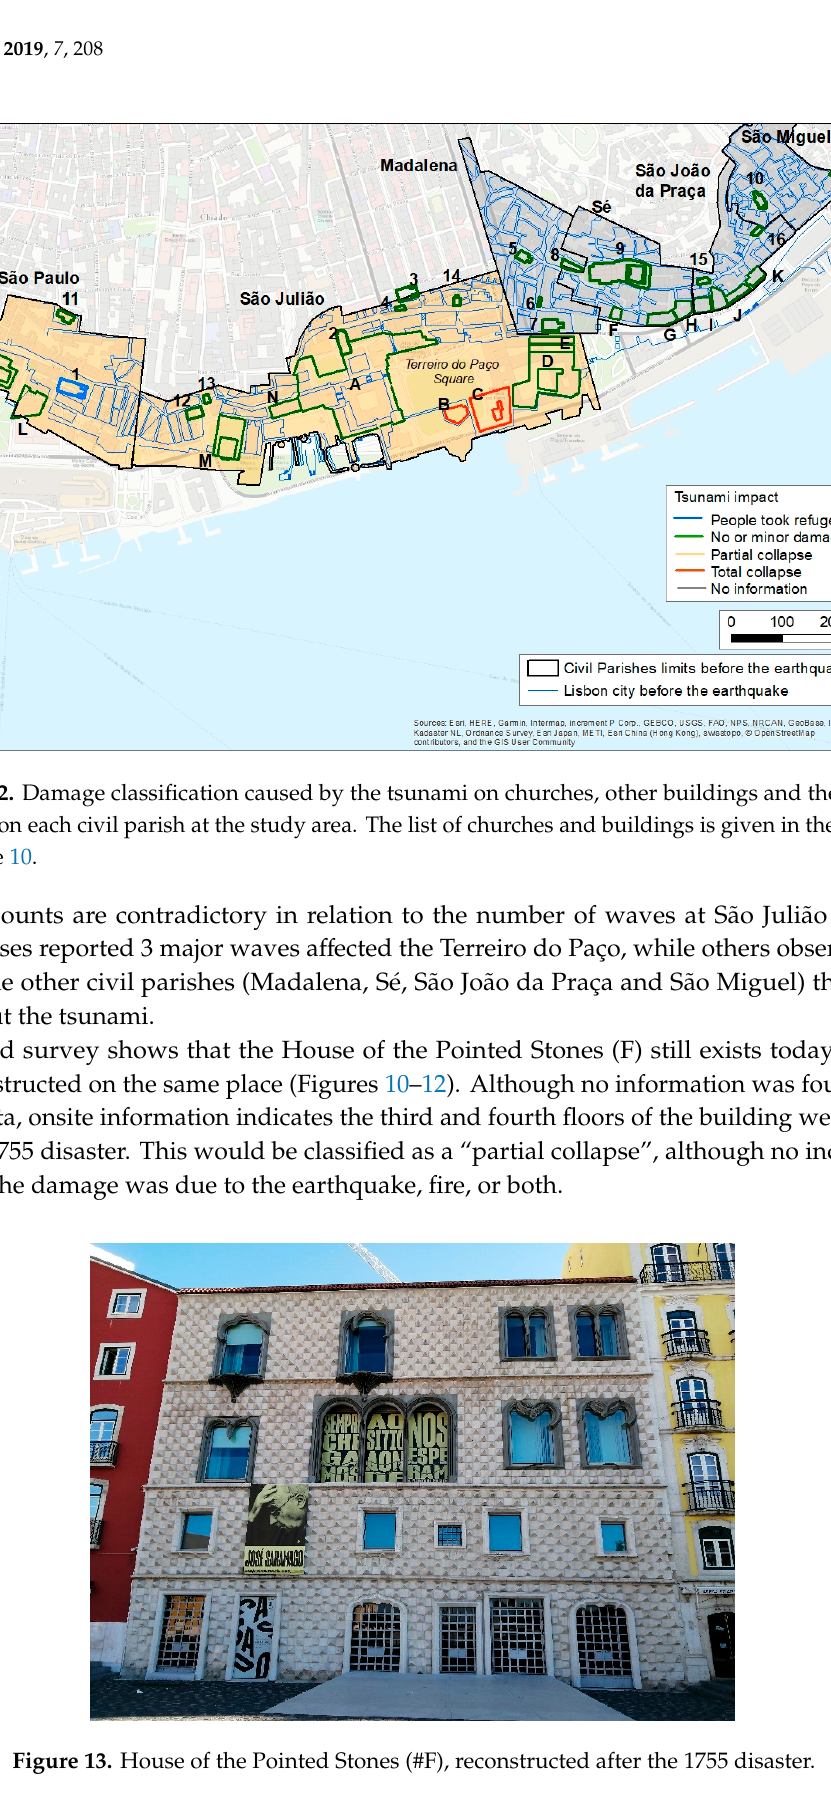
Figure 13. House of the Pointed Stones (#F), reconstructed after the 1755 disaster.